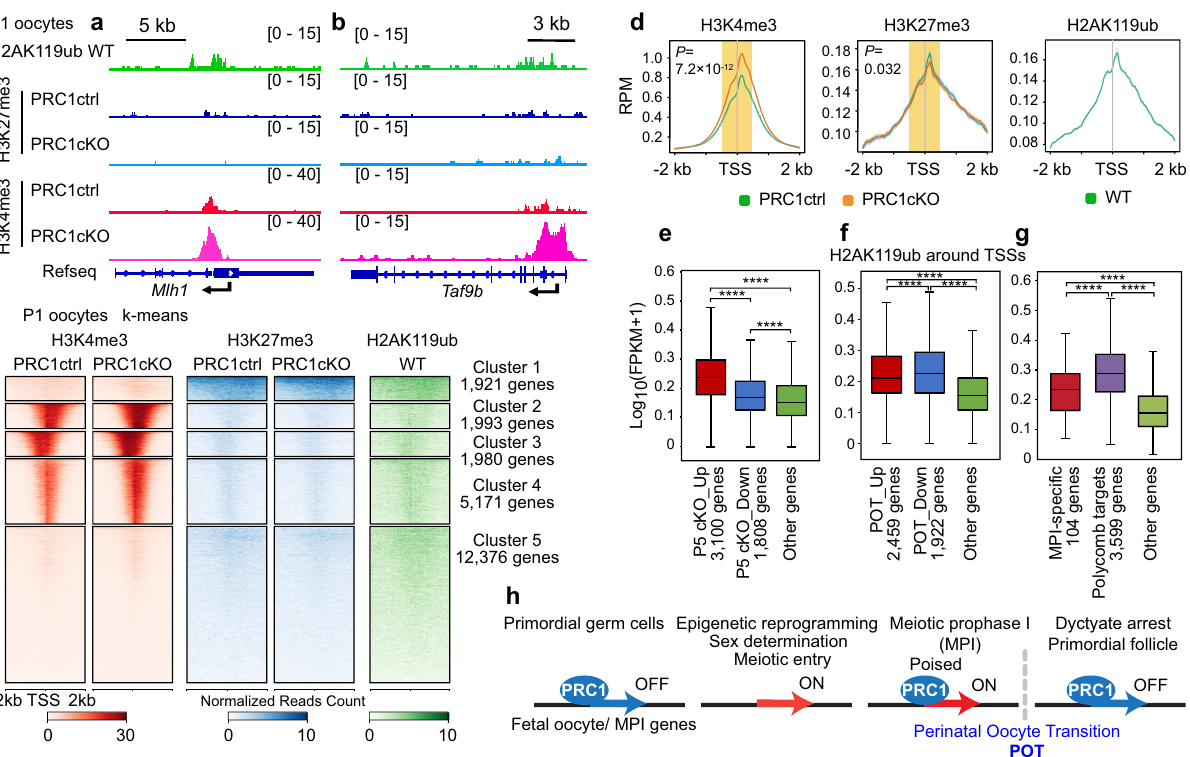
Fig. 4 Removal of PRC1 affects the global deposition of H3K4me3 in oocytes. a , b Representative track views showing H2AK119ub, H3K4me3, and H3K27me3 CUT&RUN peaks in P1 oocytes of indicated genotypes. Data ranges are shown in brackets. ~500 nongrowing oocytes isolated from P1 ovaries were pooled as one replicate, and two independent biological replicates were examined for CUT&RUN. c , d Heatmaps of k-means clusters and average tag density plots showing H3K4me3, H3K27me3, and H2AK119ub enrichment at promoter region (TSS±2kb) in P1 oocytes. Clusters 2 – 4 differed in H3K4me3 localization (Cluster 2: H3K4me3 accumulation on 3 ’ -side of transcription startsites (TSSs); Cluster 3: on 5 ’ -side of TSSs; and Cluster 4: on the center of TSSs), but H3K4me3 was highly accumulated in all three clusters. The bars below the heatmaps represent signal intensity, the numbers represent spike-in normalized reads counts. Wilcoxon rank-sum test(two-sided) was performed for read counts in the highlighted area (TSS±500bp). e , f , g Box-and-whisker plots showing H2AK119ub enrichment around TSS in different gene groups as indicated. Other genes: n = 50,343 ( e ), 50,868 ( f ) and 51,569 ( g ). Central bars represent medians, the boxes encompass 50% of the data points, and the whiskers indicate 90% of the data points. **** P <7.0 × 10 − 7 in e , **** P < 2.1 × 10 − 150 in f ,